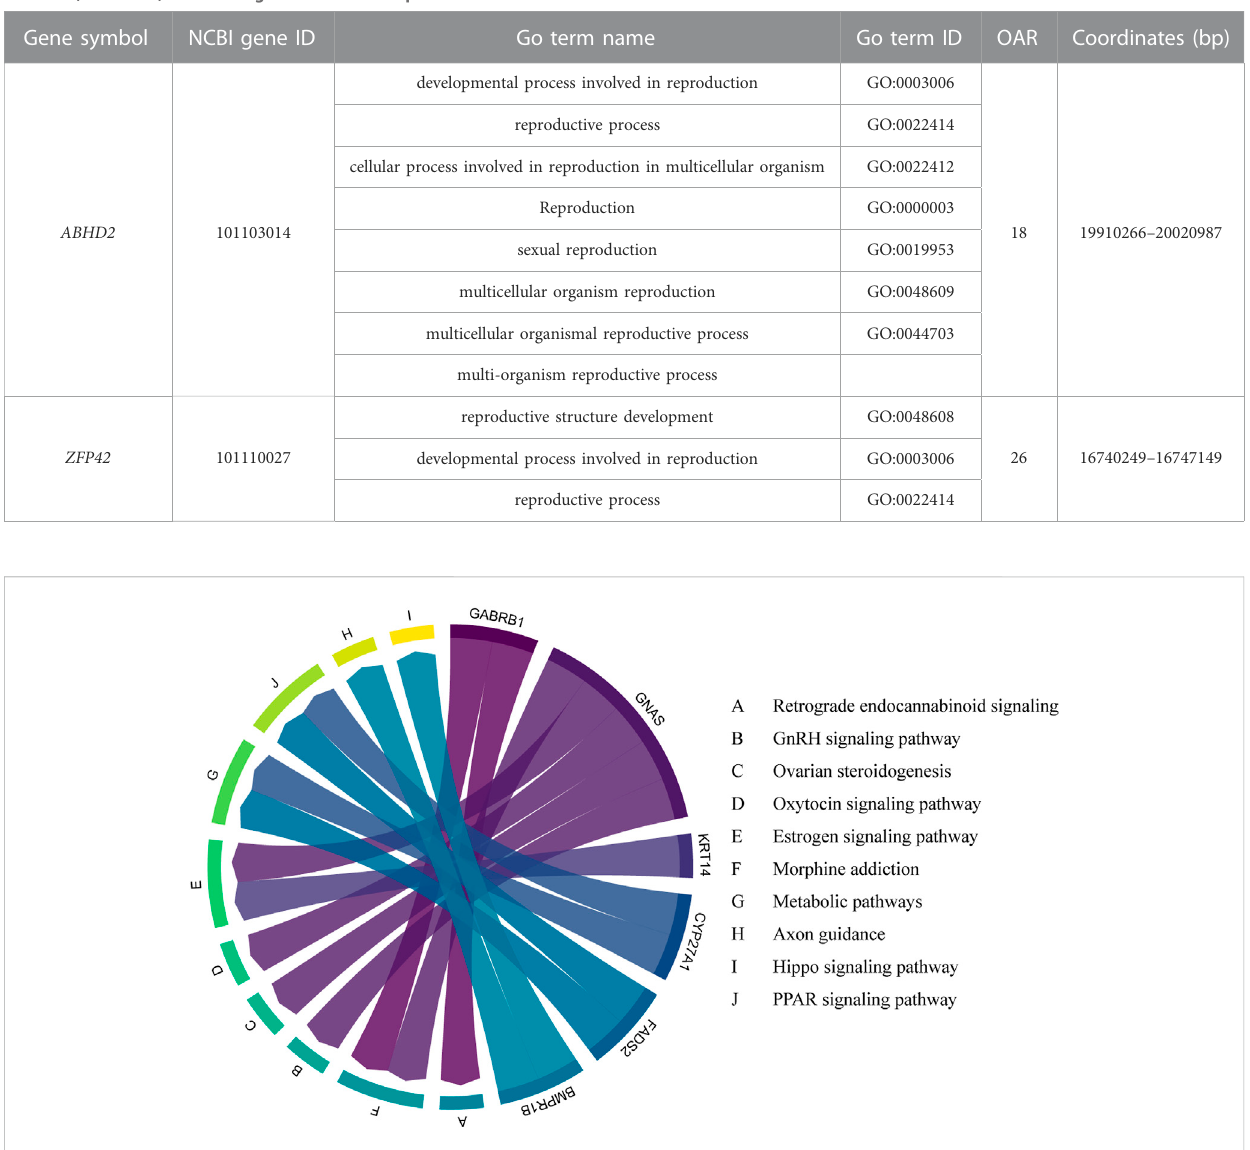
FIGURE 5 Enrichment pathways of 29 genes obtained by intersection of F ST and IHS and their relationship.